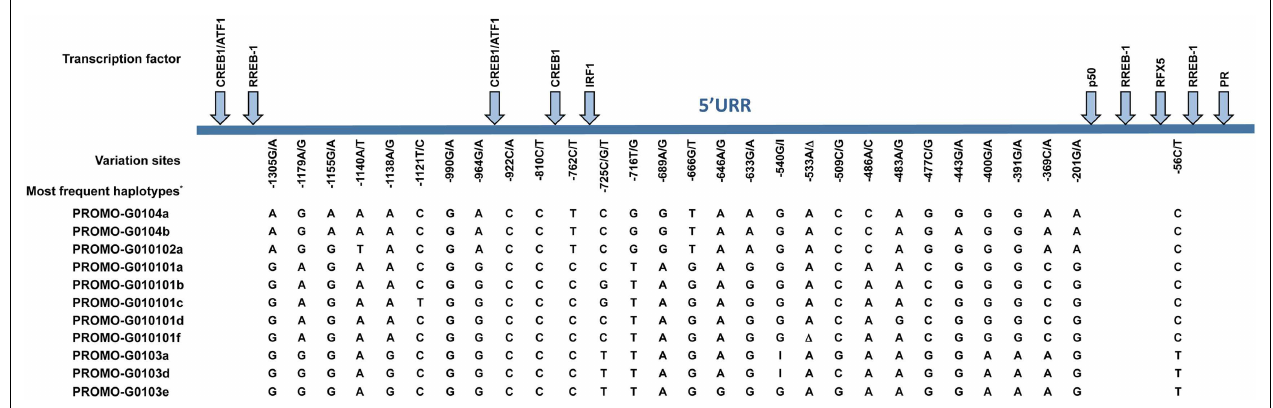
FIGURE 1 |Variation sites at the 5 (cid:48) upstream regulatory region (5 (cid:48) URR) of the HLA-G gene (1.4kb upstream ofATG), as well as the target binding sites of the described transcriptional factors .The position of the variation sites is determined in relation to Adenine of the initiation codon ATG. *Since there is no official nomenclature for 5 (cid:48) URR haplotypes, they were designed as previously reported (10).Transcription